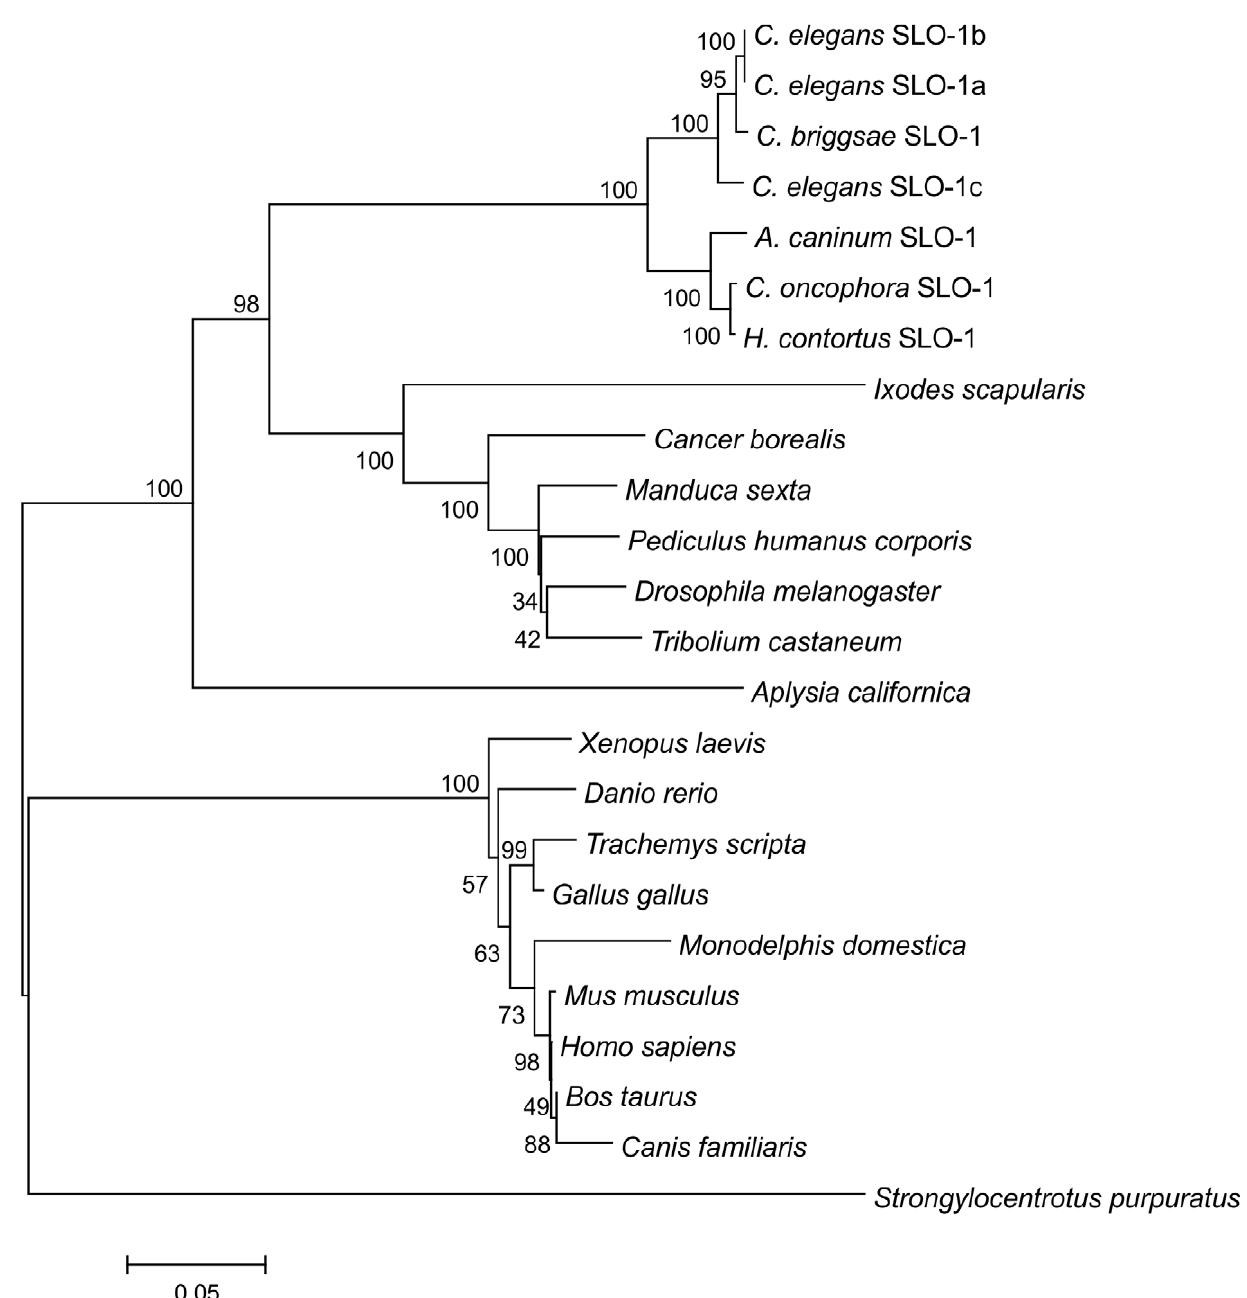
Figure 1. Phylogenetic tree of SLO-1 amino acid sequences and related potassium channels. The tree was calculated using Neighbour Joining method. Numbers at the branches indicate bootstrap values (in %, 1000 replicates). The bar shows number of substitutions per mutation site. The selected sequences (GenBank accession numbers in brackets) are as follows: C. elegans SLO-1a (AAL28102); C. elegans SLO-1b (AAL28103); C. elegans SLO-1c (AAL28104); C. briggsae hypothetical protein CBG12923 (XP_001675579.1); A. caninum SLO-1 (EU828635); C. oncophora SLO-1 (EF494185); H. contortus SLO-1 (EF494184); Ixodes scapularis putative calcium-activated potassium channel (EEC10339.1); Cancer borealis calcium- activated potassium channel (AAZ80093.4); Manduca sexta calcium-activated potassium channel alpha subunit (AAT44358.1); Pediculus humanus corporis putative calcium-activated potassium channel alpha subunit (EEB13088.1); Drosophila melanogaster slowpoke, isoform P (NP_001014652.1); Tribolium castaneum predicted protein similar to slowpoke CG10693-PQ (XP_968651.2); Aplysia californica high conductance calcium-activated potassium channel (AAR27959.1); Xenopus laevis potassium large conductance calcium-activated channel, subfamily M, alpha member 1 (NP_001079159.1); Danio rerio novel calcium activated potassium channel (CAX13266.1); Trachemys scripta calcium-activated potassium channel (AAC41281.1); Gallus gallus calcium-activated potassium channel alpha subunit (AAC35370.1); Monodelphis domestica predicted protein similar to large conductance calcium-activated potassium channel subfamily M alpha member 1 (XP_001367795.1); Mus musculus mSlo (AAA39746.1); Homo sapiens potassium large conductance calcium-activated channel, subfamily M, alpha member 1, isoform CRA_d (EAW54600.1); Bos taurus BK potassium ion channel isoform C (AAK54354.1); Canis familiaris calcium-activated K + channel, subfamily M subunit alpha-1 (Q28265.2); Strongylocentrotus. purpuratus predicted protein similar to calcium-activated potassium channel alpha subunit (XP_783726.2).